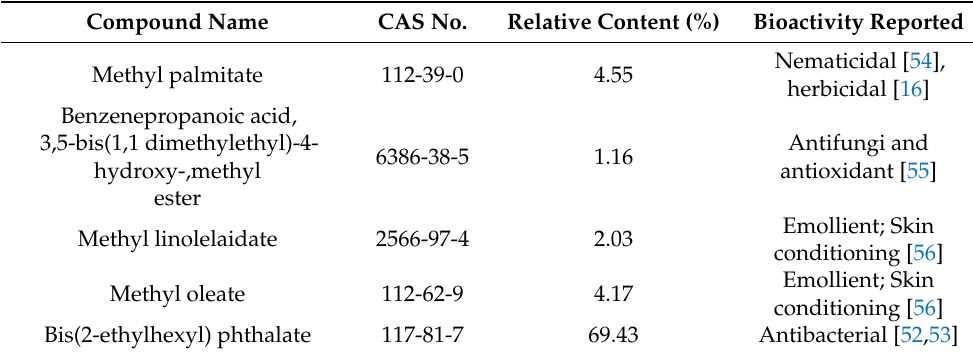
Table 4. Dominant Compounds Found in the n-Hexane Extract from the Fungus Combs and Their